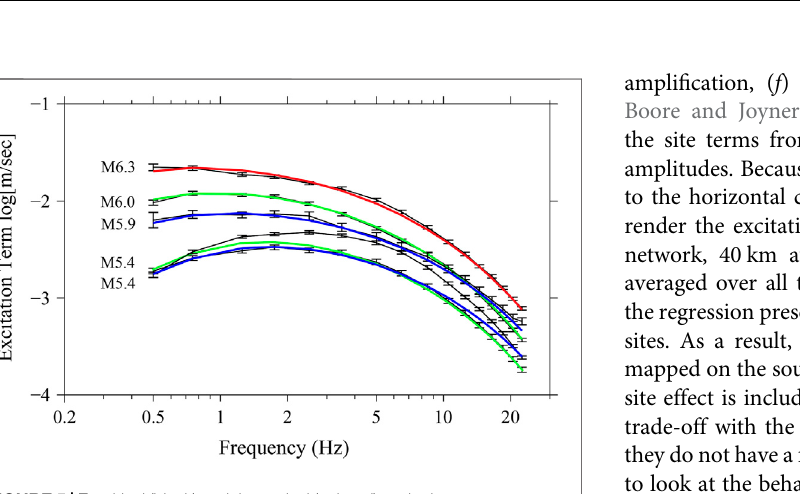
FIGURE 5 | Empirical (black) and theoretical (colored) excitation spectra at40 kmdistanceobtainedforthepeakofthe fi lteredamplitudesderivedfrom RVT synthetics in the frequency range from 0.5 to 22.5 Hz. The green, blue, and red lines show the predicted excitation terms obtained by using Eq. 6 , at the moment magnitudes corresponding to those calculated for the plotted events M6.0 and M5.4 with Q( f )=115 ± 45 f 0.50±0.12 , events M5.9 and M5.4 with Q( f ) = 55 ± 5 f 0.8 ± 0.025 , and M6.3 Norcia earthquake with Q( f )=70 ± 15 f 0.65±0.1 ,